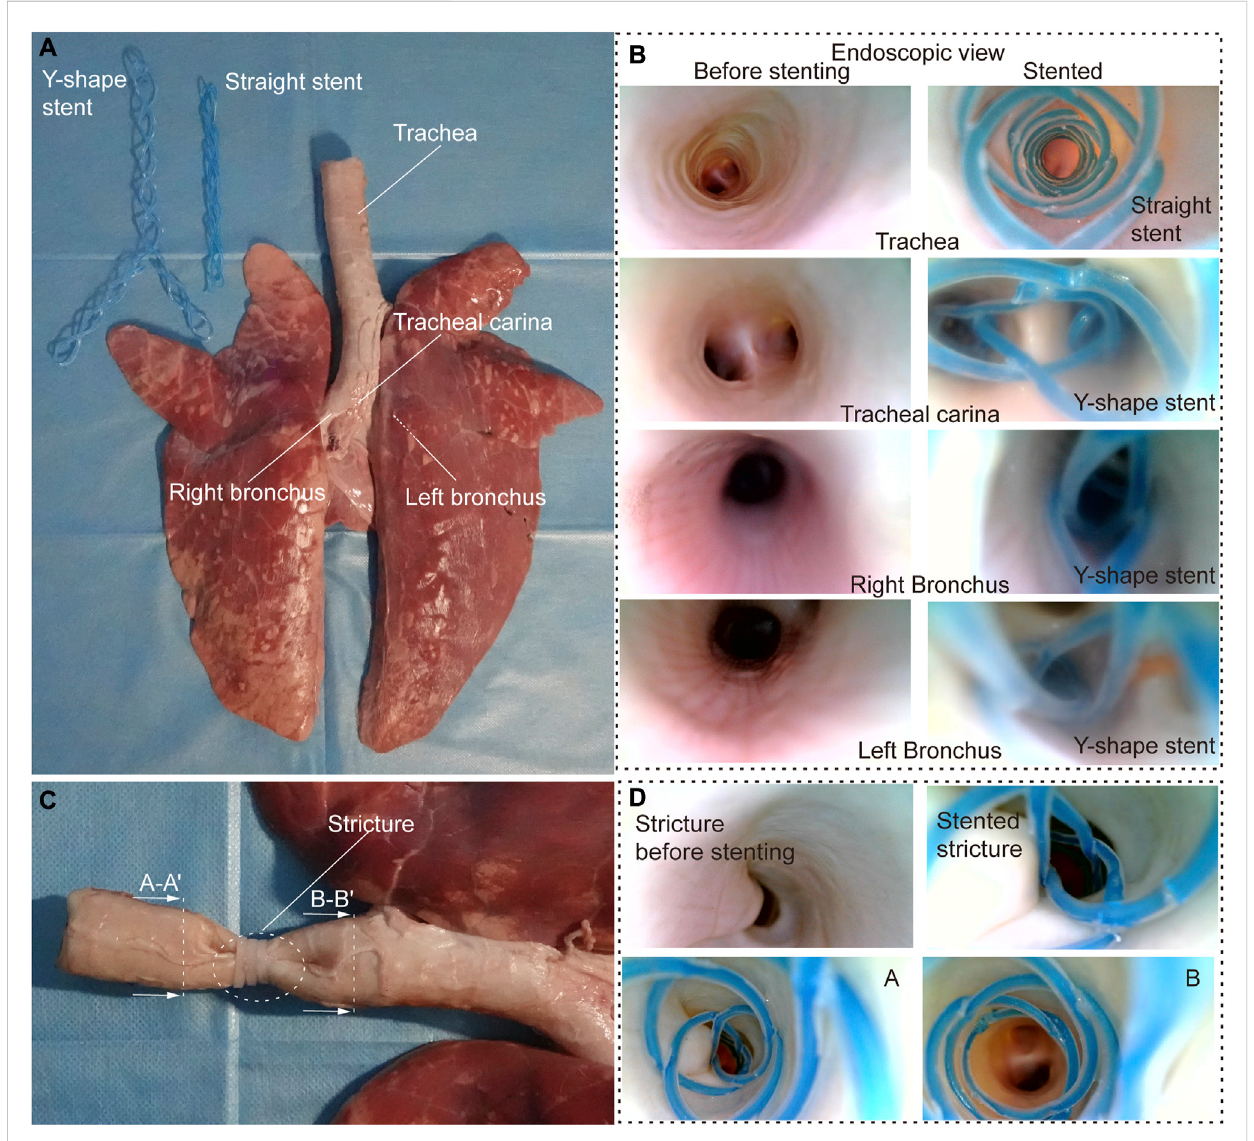
FIGURE 5 Ex vivo experiments. (A) Ex vivo swine airways and two types of stents used in the experiment. (B) Endoscopic view before (left) and after (right) stenting of the inner walls of the trachea, trachea carina, right and left bronchus. (C) Stricture created to simulate stenosis in the ex vivo trachea. (D) Endoscopic view before and after stenting in ex vivo trachea with